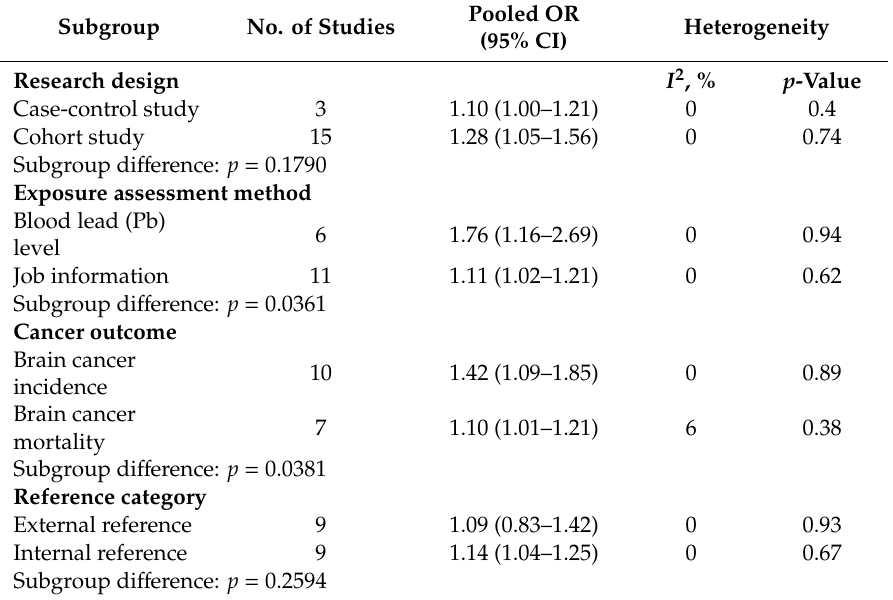
Table 3. Results of subgroup analyses of malignant brain